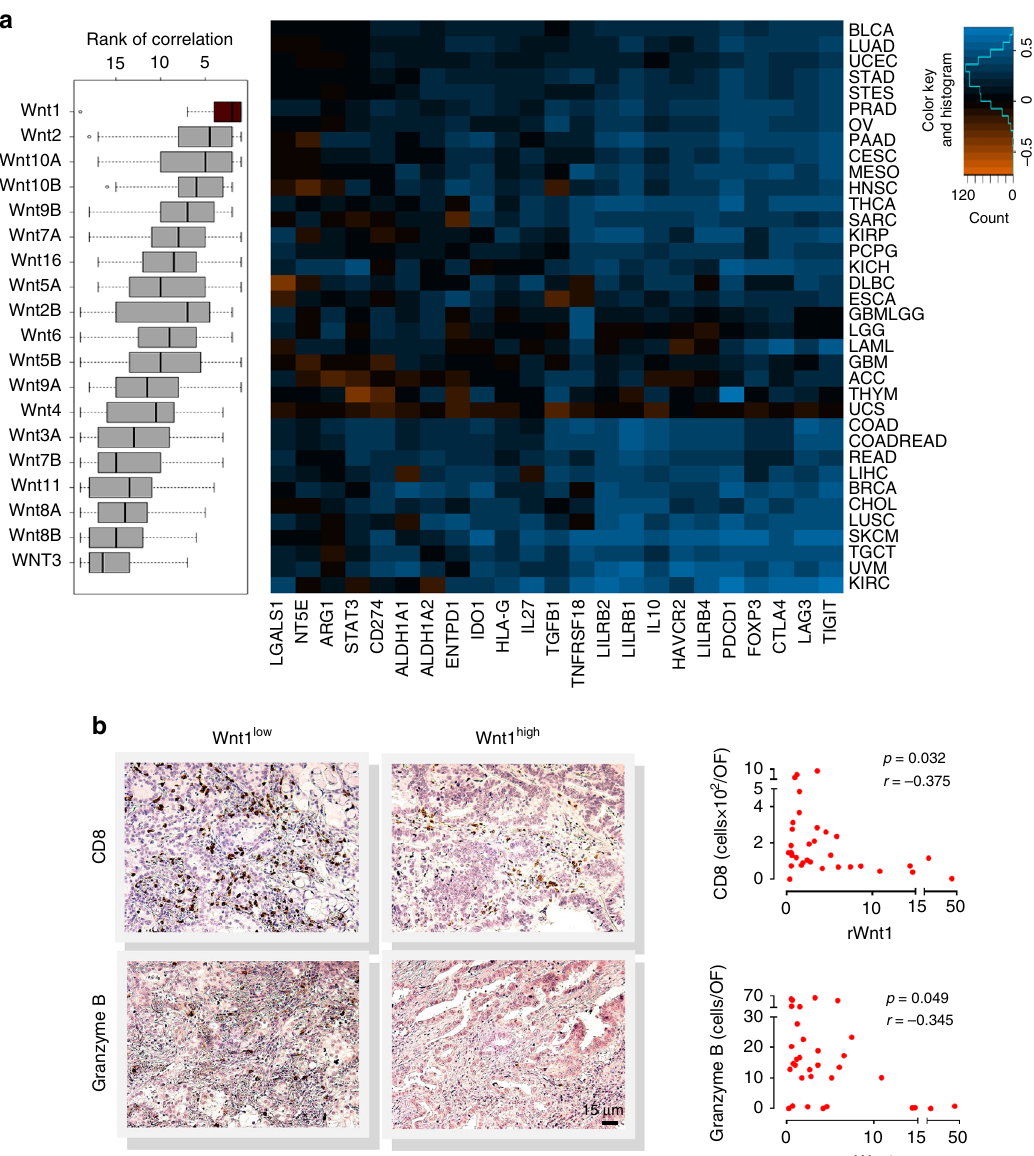
Fig. 1 Upregulation of Wnt1 in adaptive immune resistant human tumors. a Distributions of the ranks of correlations between Wnt ligand gene expression and expression of 23 immunosuppressive genes across all cancer types of the TCGA dataset (>11,000 tumors) (Left) and heatmap representing color- coded Pearson correlations for Wnt1 (Right). Column side annotations are names of immunosuppressive genes and row side annotations are names of TCGA cancer types. b CD8 + T cytotoxic cells and granzyme B + cells identi fi ed as brown stained cells by immunohistochemistry (IHC) in paraf fi n- embedded human tumor sections (Left). Scatterplots depicting the relationship between Wnt1 gene expression (RT-PCR) and numbers of CD8 + and granzyme B + cells per tumor optical fi eld (OF) (IHC). Pearson Correlation. (Right). Each point represents a single donor ( n = 33). Source data are provided as a Source Data fi